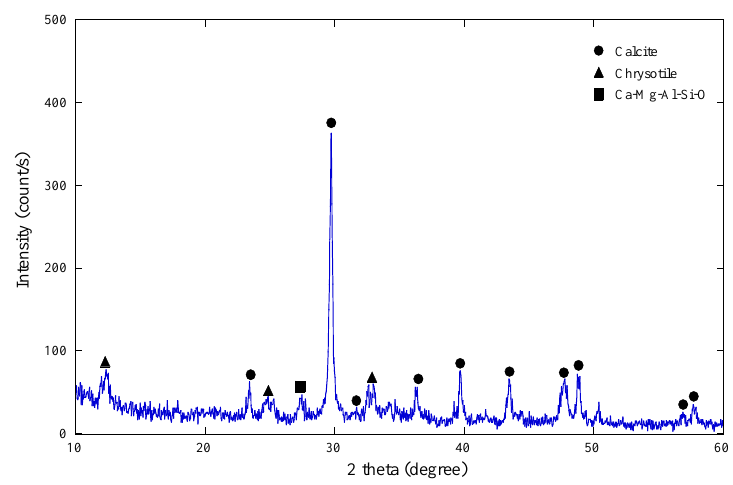
Figure 1. X-ray diffraction (XRD) patterns of as-received waste slate.